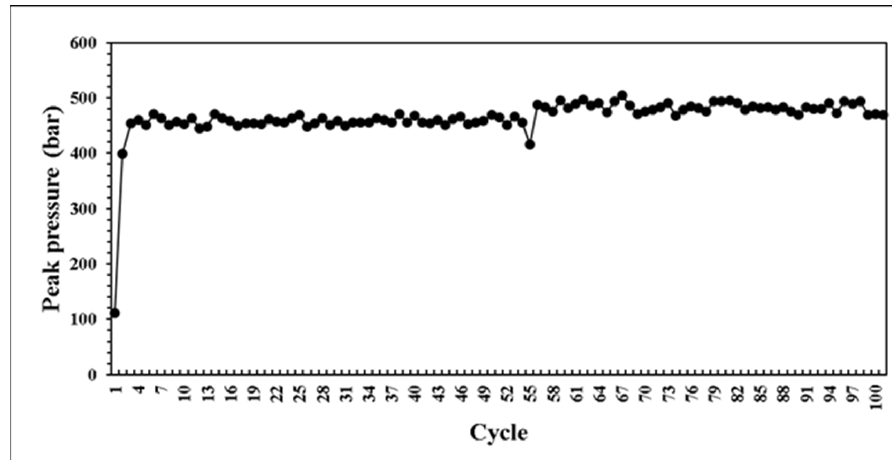
Figure 22. Distribution of peak pressure in experiment.